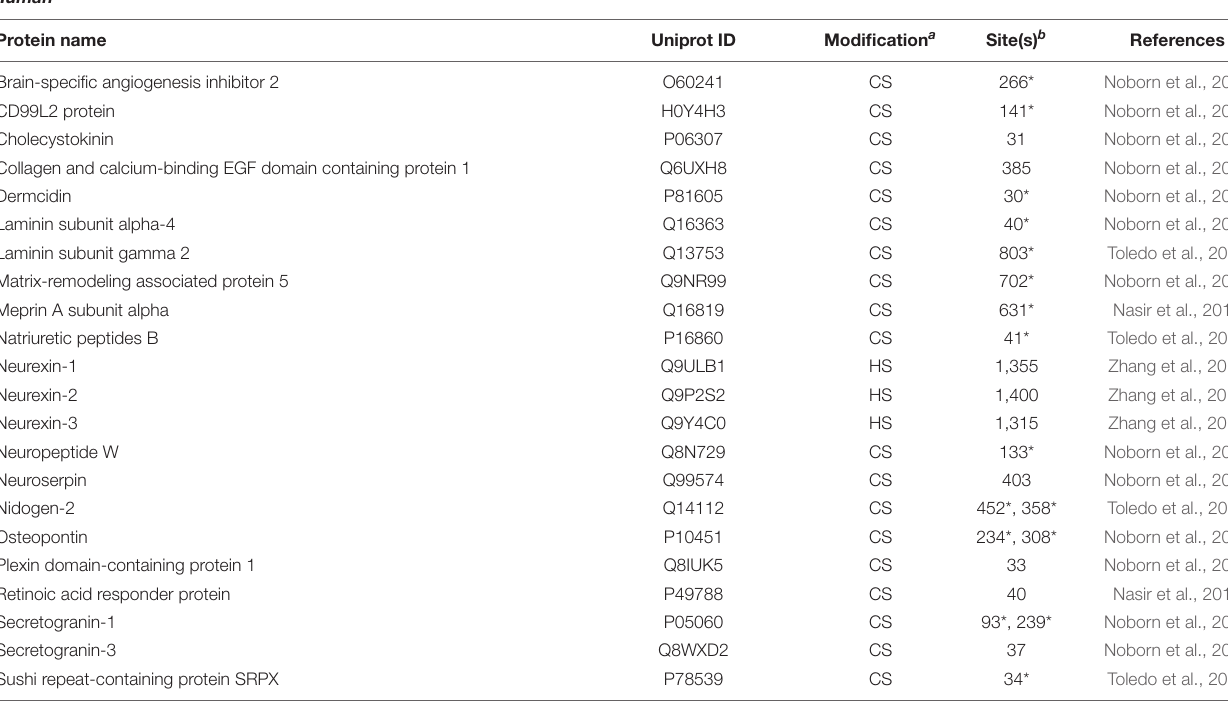
TABLE 1 | A. Novel human proteoglycans identified through